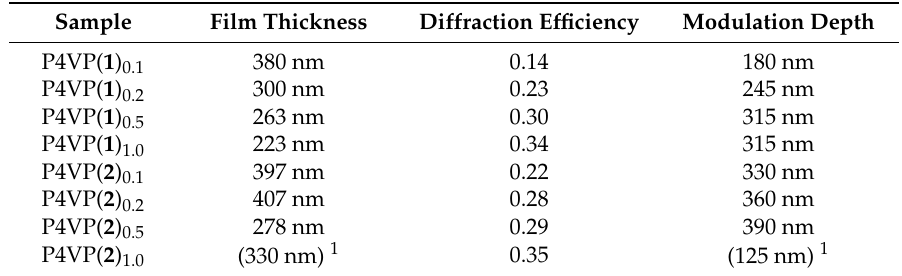
Table 1. Summary of the SRG experiments, including the thicknesses of the films used, the diffraction efficiencies, and the modulation depths of the gratings (with an error margin of ±15 nm) as determined from the AFM images. The measurements were performed after completion of the SRG formation, which occurred between 1 and 2 h depending on the sample.